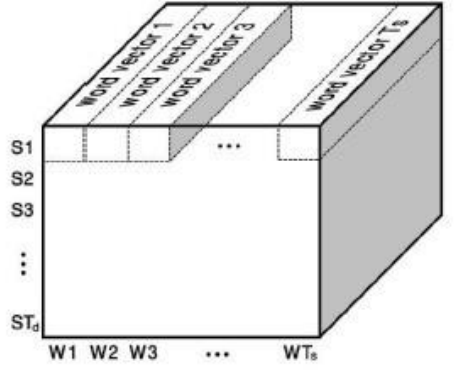
Fig. 2. Shape of the converted documents.